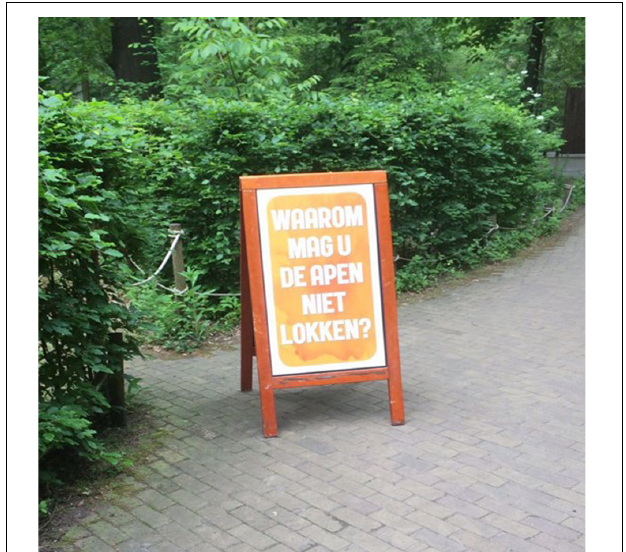
FIGURE 1 | Signs with arguments in favor of the non-luring rule.